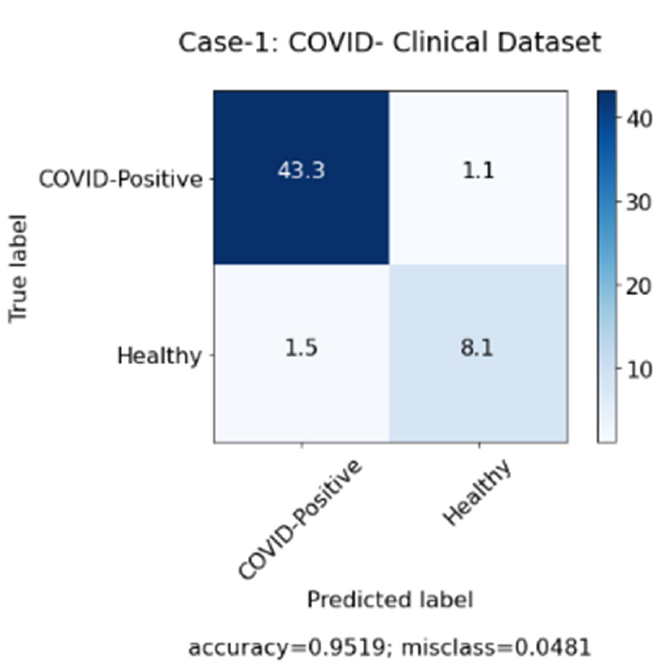
Figure 6. Confusion matrix for case 1 (clinical data).